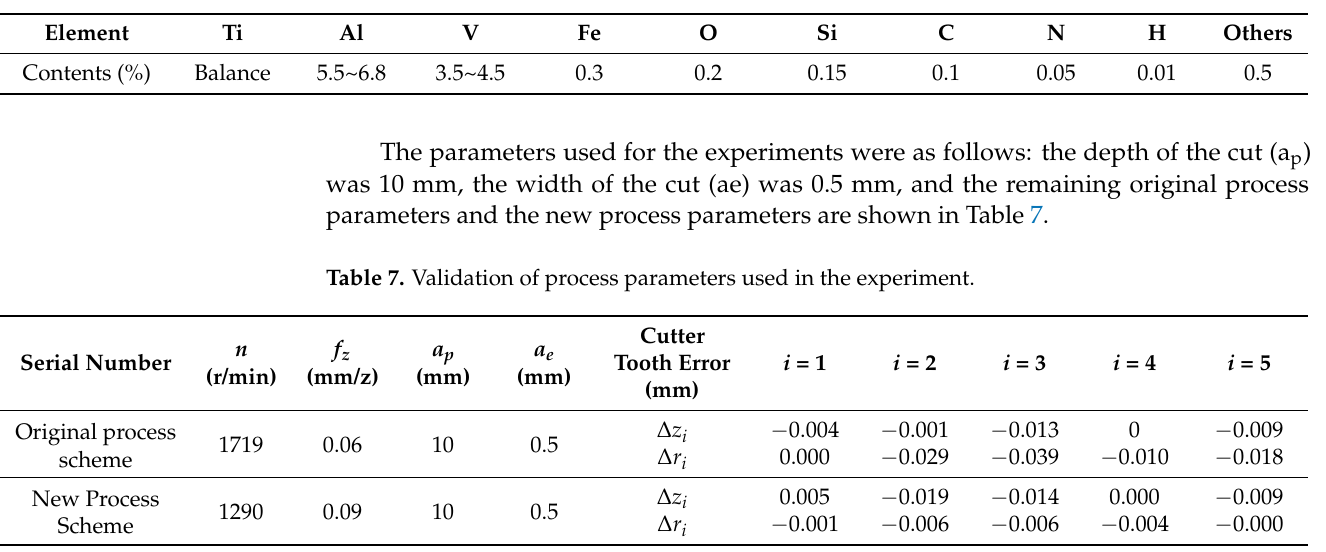
Table 6. The material composition of the TC4 titanium alloy workpiece.